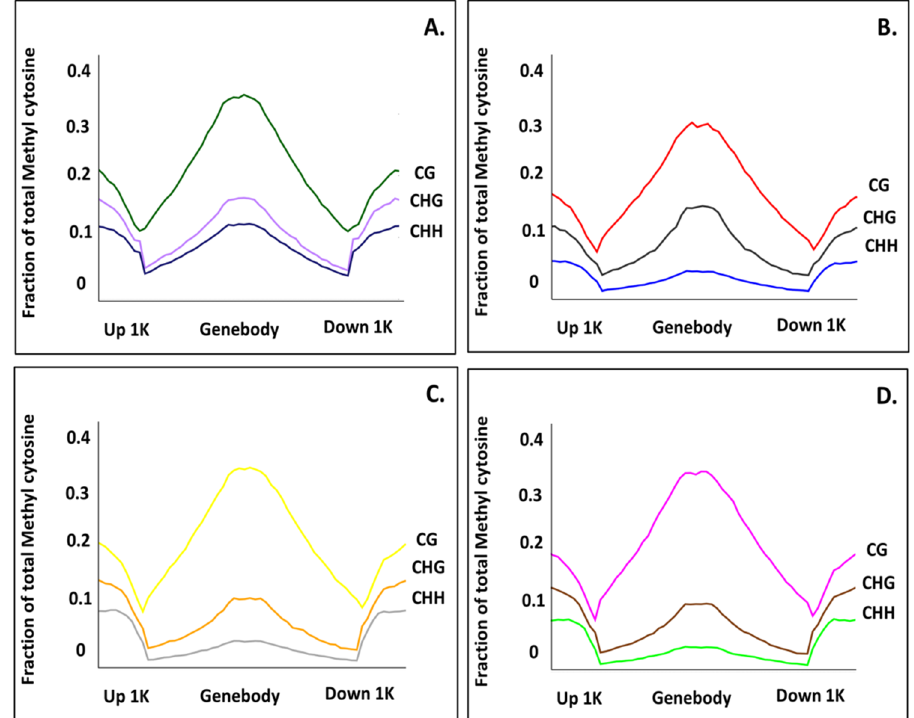
Figure 4. Line plots showing methylation levels in gene body, upstream and downstream flanking regions (up to 1 Kb) in ( A ) healthy flowering (HF) ( B ) phyllody affected (I1) ( C ) healthy vegetative (H1) ( D ) little leaf affected (LL) samples in CG (Top most line), CHG (Middle line) and CHH contexts (lower line).